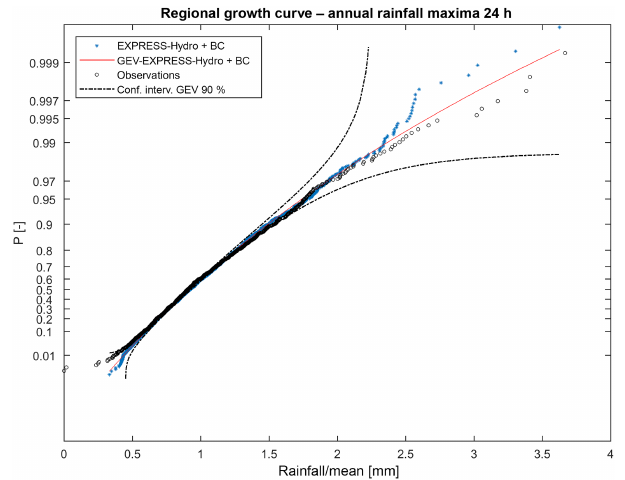
Figure 7. Growth curve obtained by annual maxima of 24h accumulated rainfall. Observations (blue dots) compared with EXPRESS-Hydro reanalysis (black dots). The red line is the GEV distribution fitted on EXPRESS-Hydro values, while dotted lines are the confidence intervals with a 95%